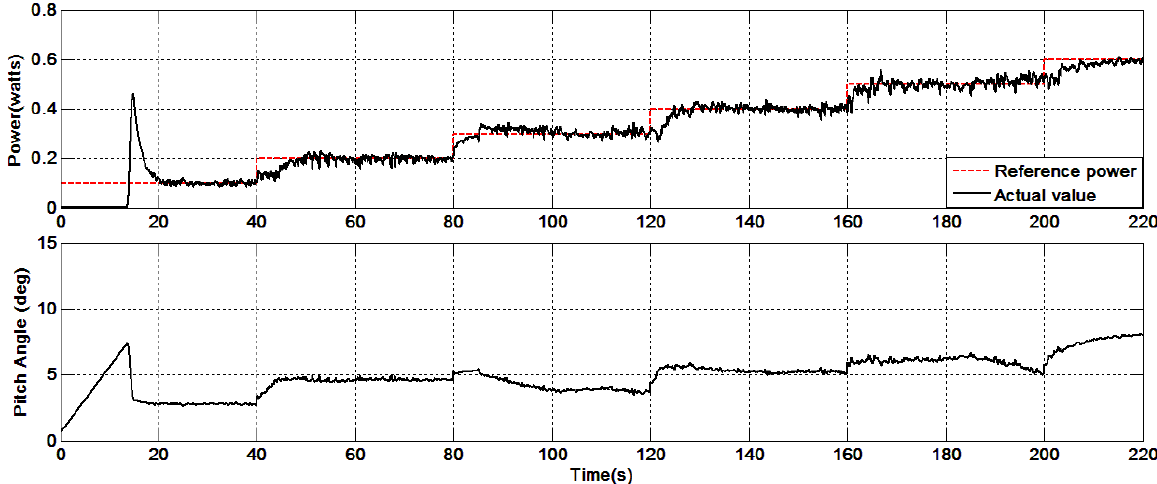
Figure 11. Generated power and pitch angle under PI fluctuation controller.